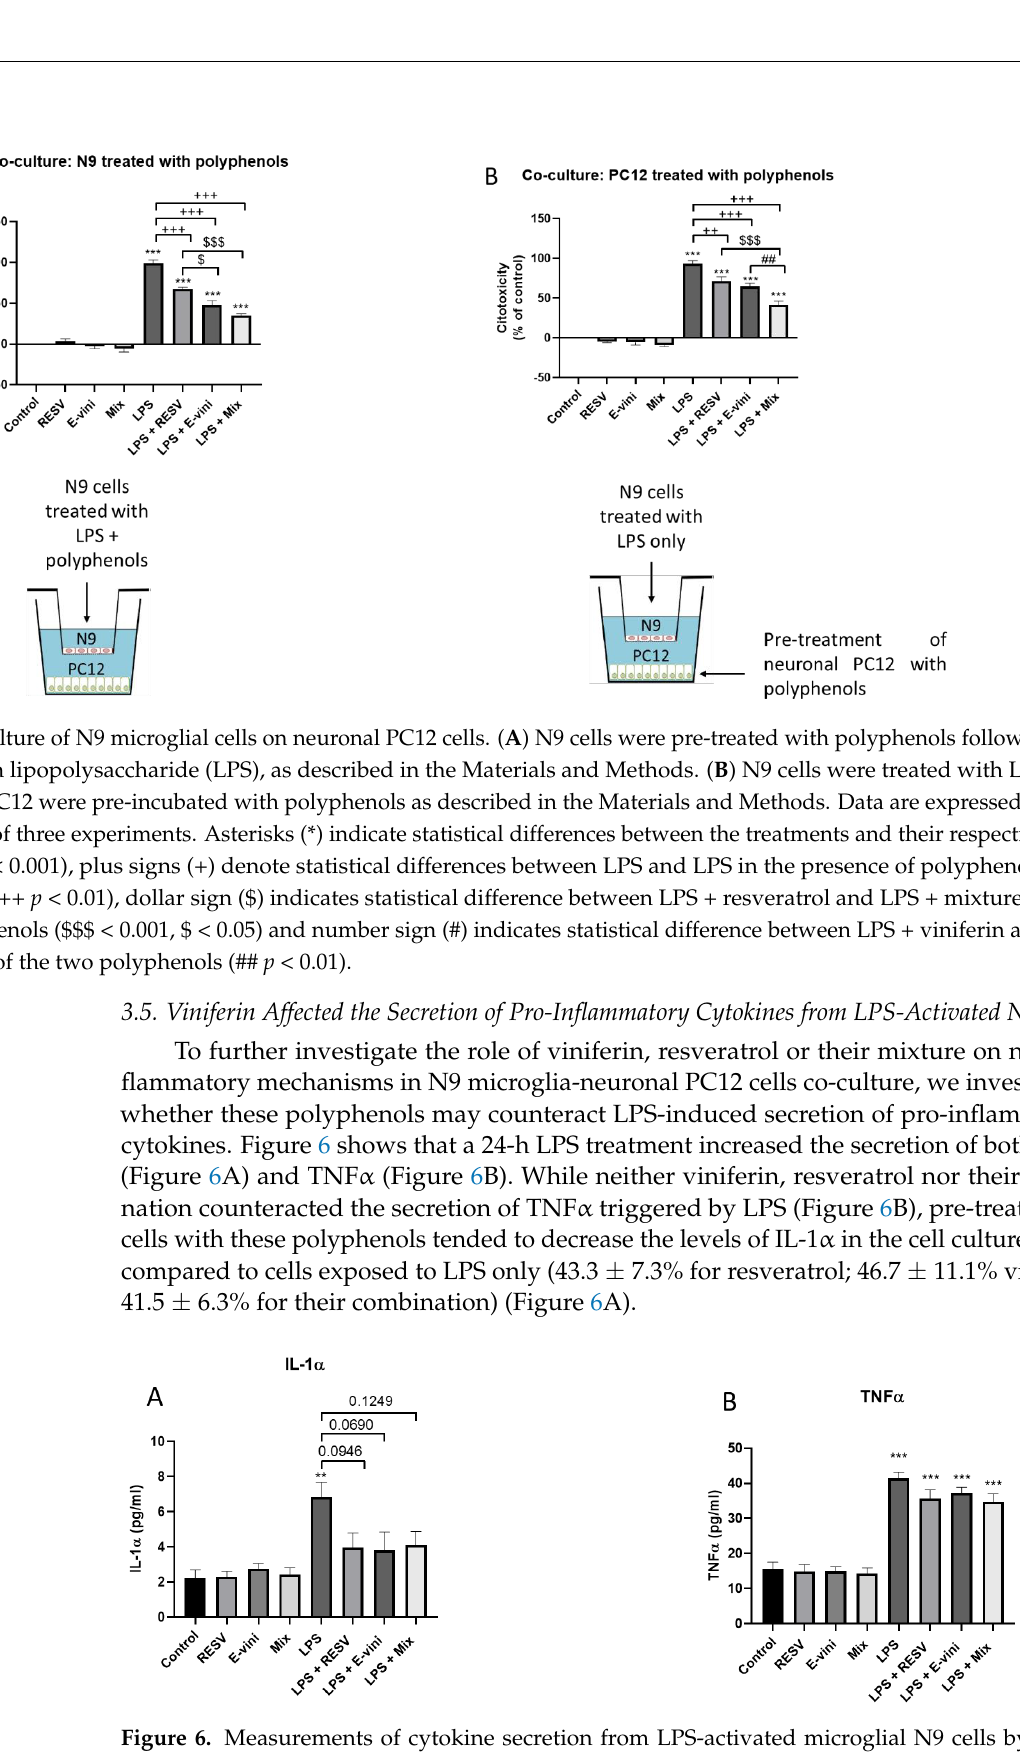
Figure 6. Measurements of cytokine secretion from LPS-activated microglial N9 cells by ELISA specific kit for IL-1α ( A ) and TNFα ( B ). Data are expressed as means ± SEM of four experiments. Asterisks (*) indicate statistical differences between specific kit for IL-1 α ( A ) and TNF α ( B ). Data are expressed as means ± SEM of four experiments. the treatments and their respective controls (*** p < 0.001, ** p < 0.01). Asterisks (*) indicate statistical differences between the treatments and their respective controls (*** p < 0.001, ** p <